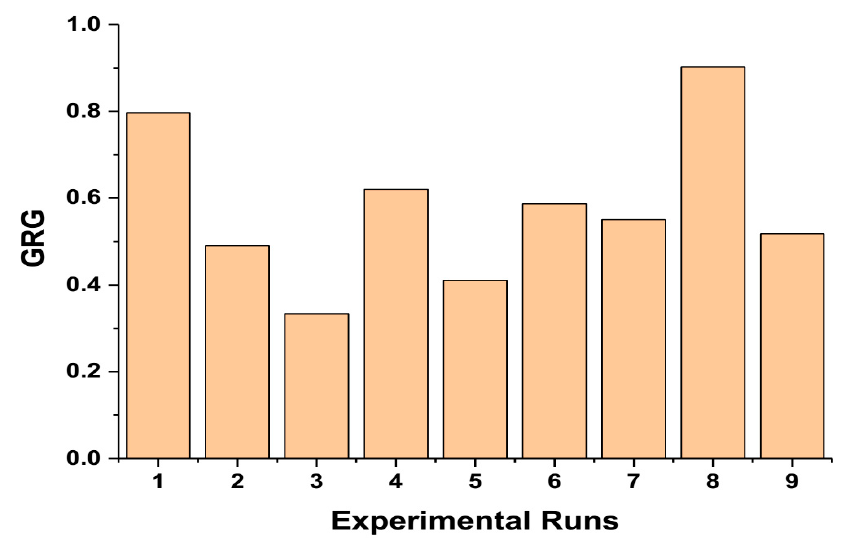
Figure 6. GRG vs. Experimental runs. Table 7. Estimation of Normalized, Deviated, GRC ( (cid:2022) = 0.5), GRG, and Rank Expt.